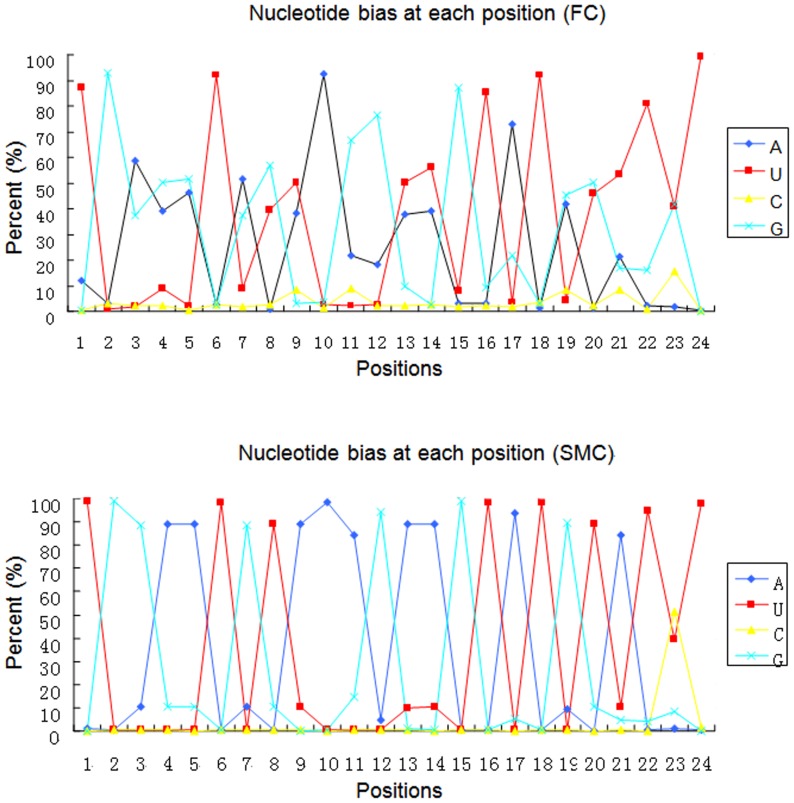
Nucleotide bias at each position.Nucleotide bias at each position (1–24) for known miRNAs. SMC: six month-old caprine muscle tissue; FC: fetal caprine muscle tissue.